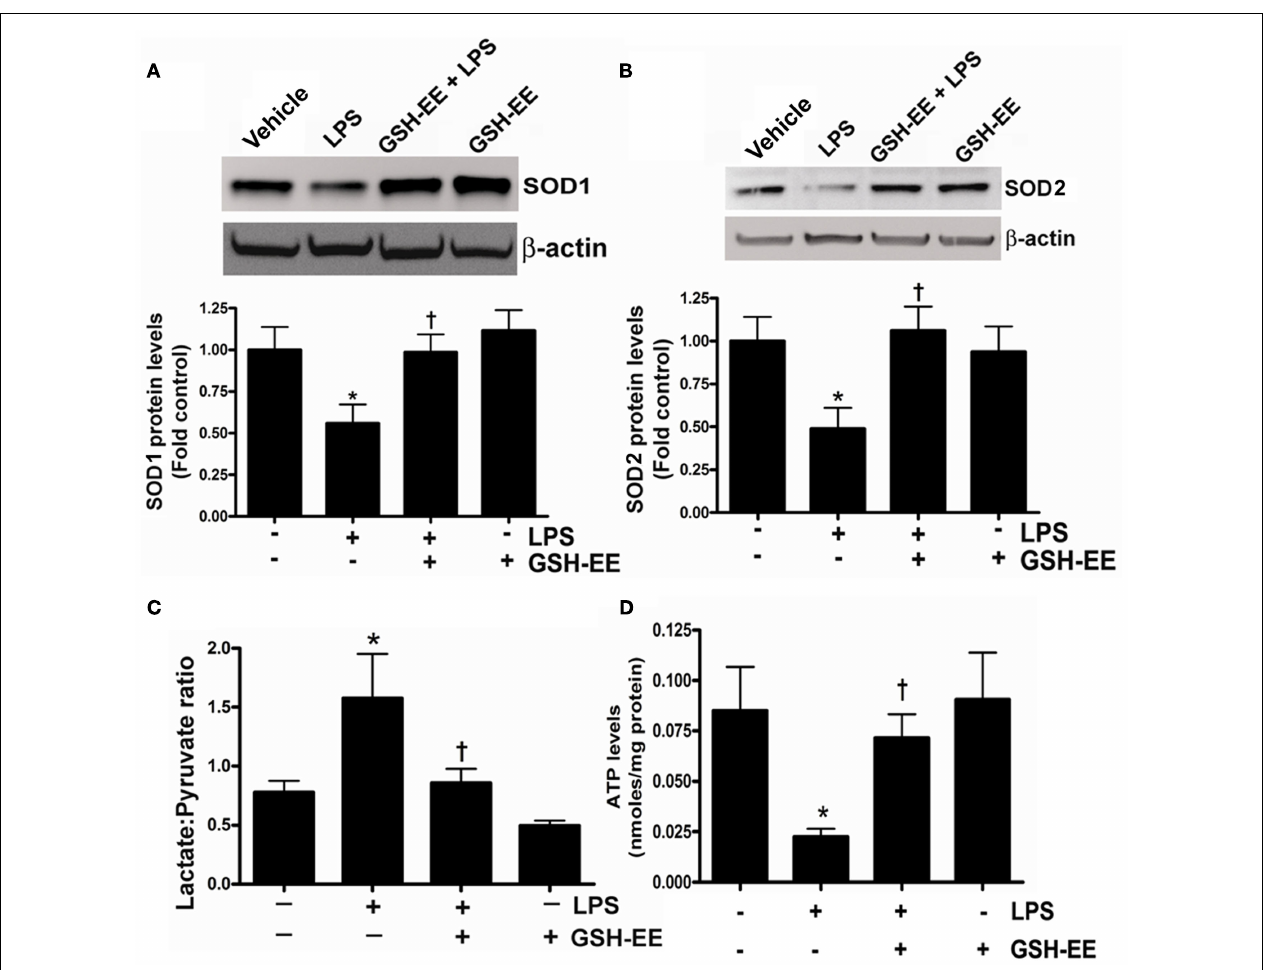
mice and this was prevented by GHS-EE pre-treatment.The lactate/pyruvate ratio was also determined in all four groups (C) . LPS-exposed mice had a significantly higher lactate/pyruvate ratio (C) . Pre-treatment with GSH-EE preserved the lactate/pyruvate ratio.There was a significant reduction in lung ATP levels after LPS exposure (D) . However, the LPS-mediated decrease in ATP levels was not observed in mice pre-treated with GSH-EE (D) .Values are mean ± SEM; n = 6/group. * P < 0.05 vs. vehicle; † P < 0.05 vs.